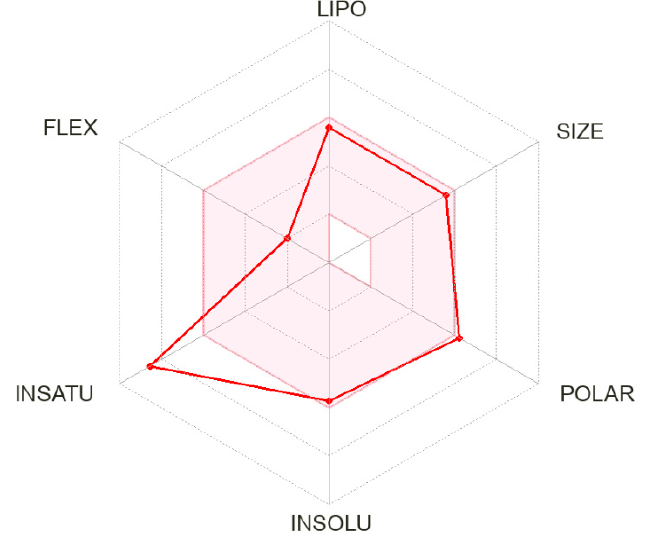
Figure 3. The bioavailability radar of chromeno[2,3- b ]pyridine ( 4 ).